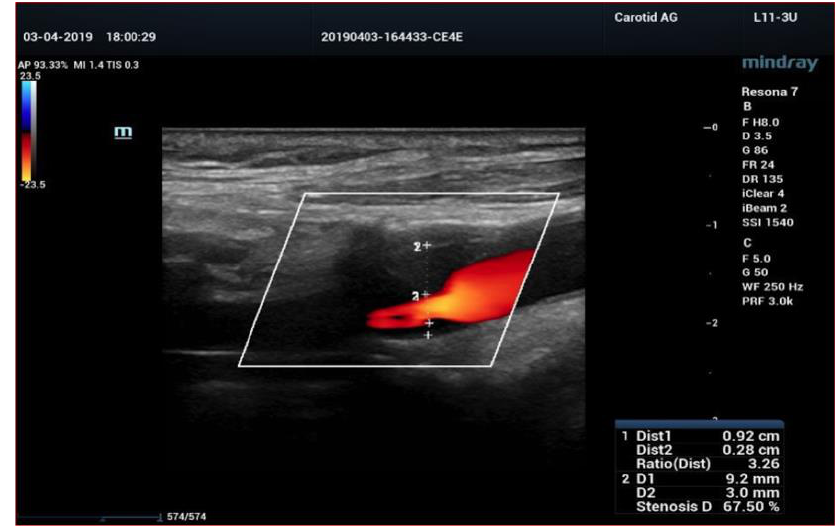
Figure 4. CDUS carotid stenosis measured by ECST method. The combined peak systolic frequency (PSF), peak systolic velocity (PSV), and end- diastolic velocity (EDV) serve as criteria for the ultrasound assessment of a carotid stenosis degree greater than 70%.